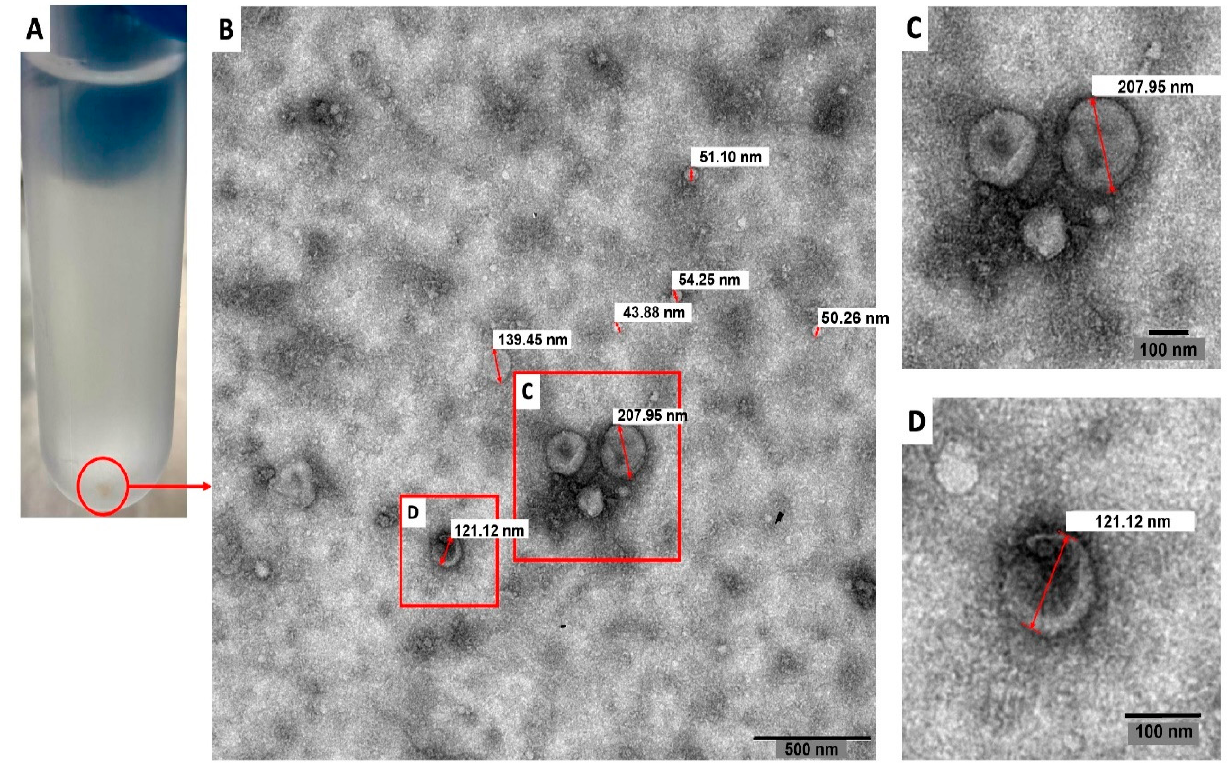
Figure 1. Transmission electron microscopy image of extracellular vesicles secreted by trophozoites of Naegleria fowleri . A pellet of extracellular vesicles obtained after the isolation procedure employed is shown in ( A ). The content of these pellets was analyzed using transmission electron microscopy and vesicles of different diameters were obtained ( B ) (43.88 nm; 50.26 nm; 51.10 nm, 54.25 nm; 121.12 nm; 139.45 nm and 207.95 nm in this image). Magnified images of ( C , D ) are also shown. Representative image of three different samples analyzed.